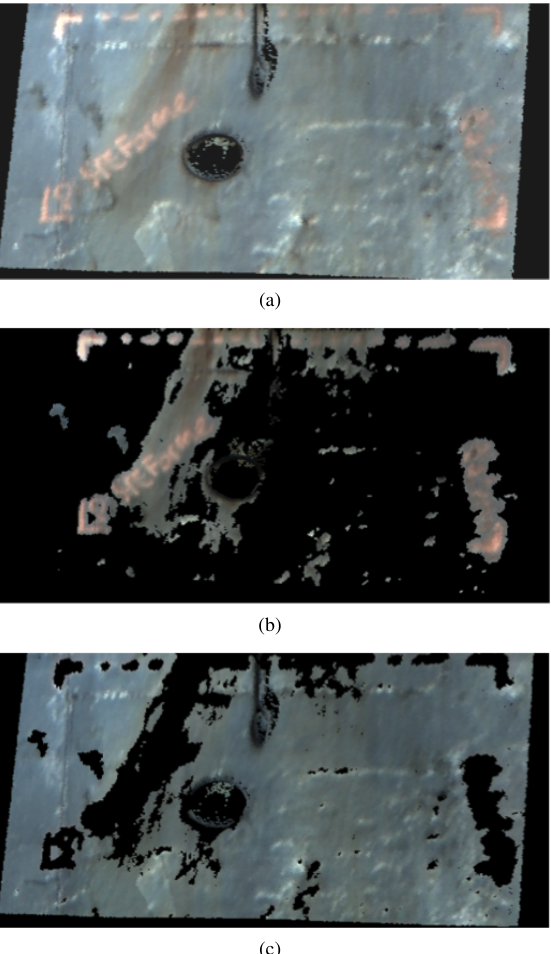
Figure 4. (a) shows the colored 3D point cloud of a small part of a selected zone. (b) shows the corroded region segmented out after detection while in (c) we find the 3D point cloud with the corroded region extracted